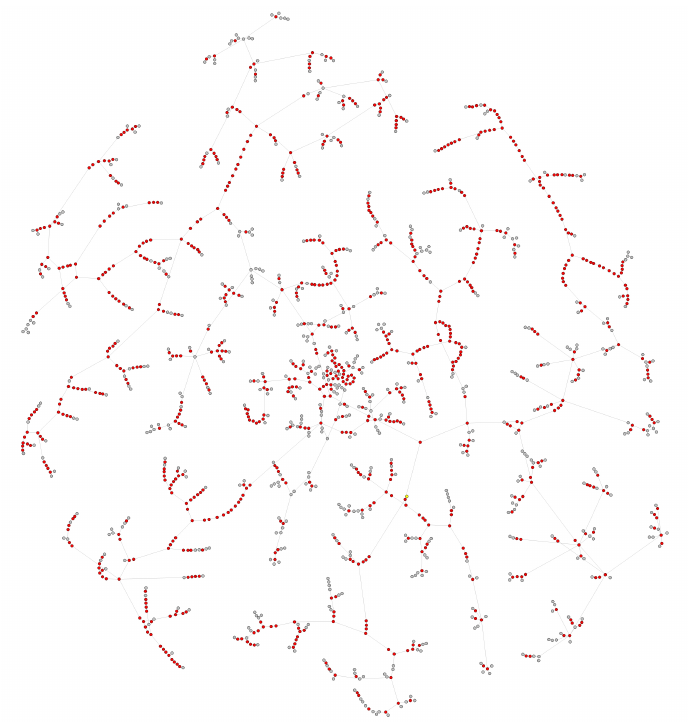
Figure A7. The inferred New Zealand transmission